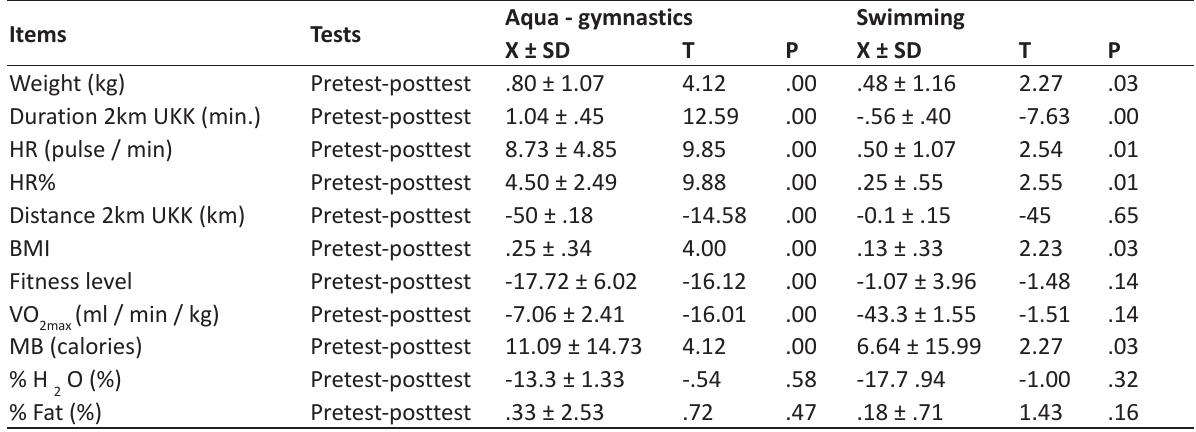
Table 2 . Descriptive statistics for the results of the tests of somatic and functional for aqua-gymnastics and swimming groups, between pretest and